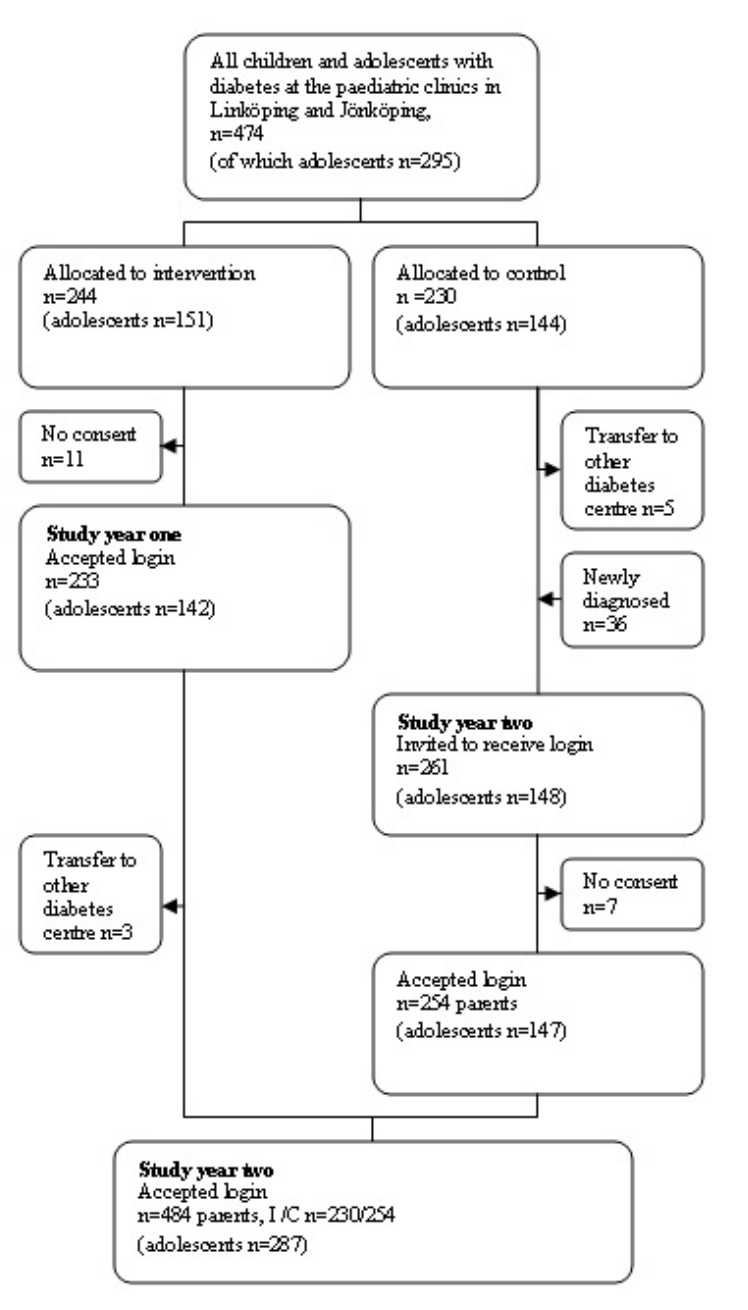
Figure 4. Flow chart of the intervention and the control